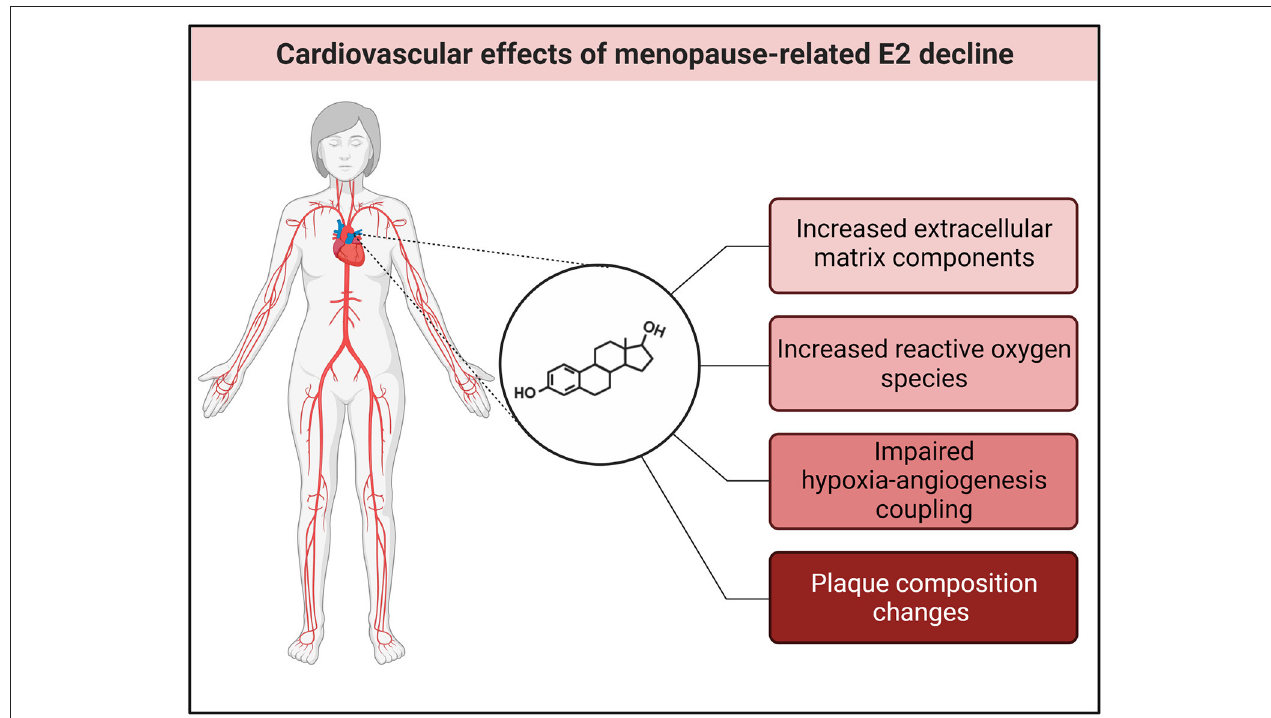
FIGURE 1 | E2 effects in the cardiovascular system. The decline of E2 at menopause may lead to an increase in extracellular matrix (ECM) components and reactive oxygen species (ROS), impaired hypoxia-angiogenesis coupling and increased atherosclerotic plaque formation. Created with BioRender.com.